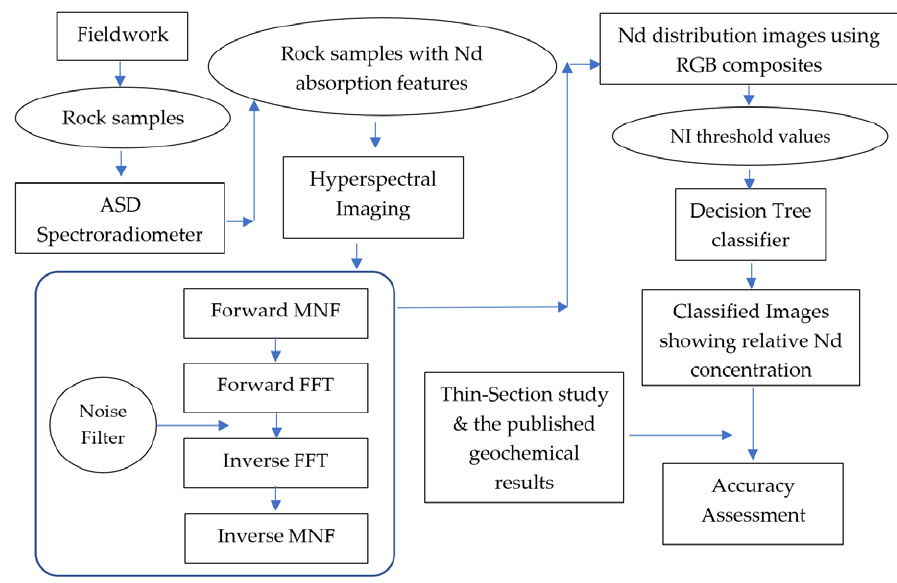
Figure 2. Flowchart showing the methodology adopted in the study (ASD: Analytical Spectral Device; FFT: Fast Fourier Transform; MNF: Minimum Noise Fraction; NI: neodymium index). Fieldwork was conducted in the Sillai Patti area, and nine rock samples were ran- domly collected along the carbonatite body (Figures 3 and 4). Spectral reflectance data and laboratory-based hyperspectral images were obtained for these nine samples. Thin sections were investigated using a petrographic microscope to correlate the spectral re- sults with the mineralogy of the samples.